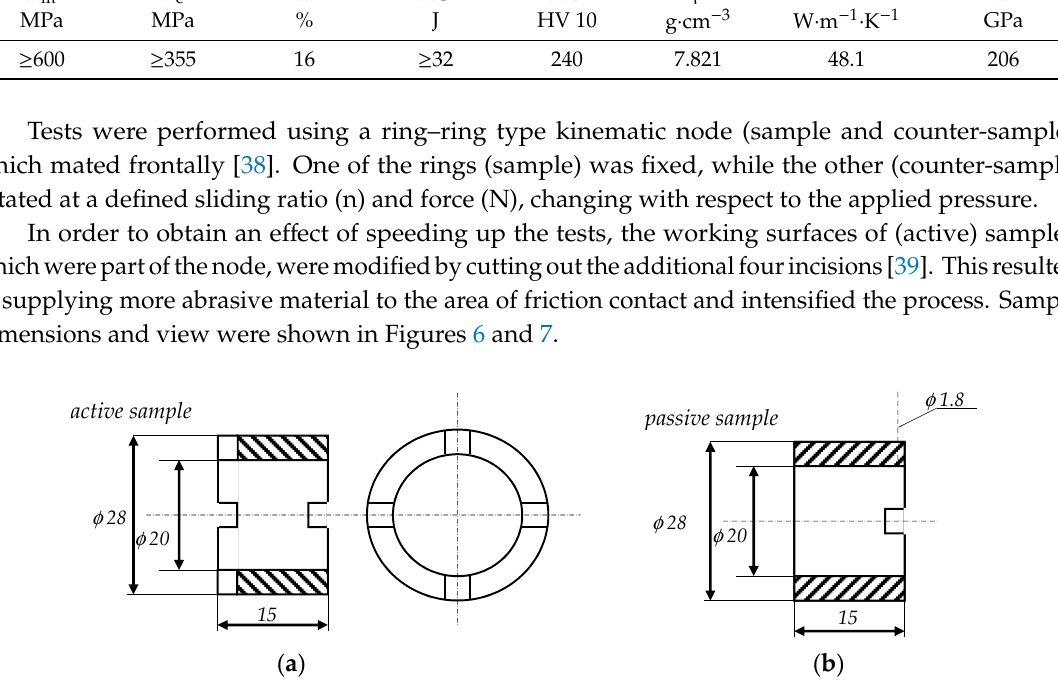
Figure 6. Sample dimensions: ( a ) active sample (the option with incisions) and ( b ) passive sample (the option without incisions) [40].